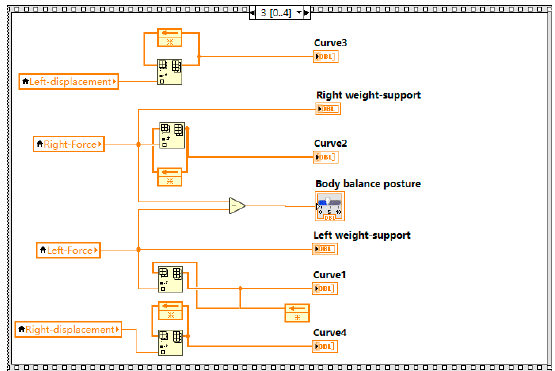
Figure 10. The rear panel of displacement and tension sensor.